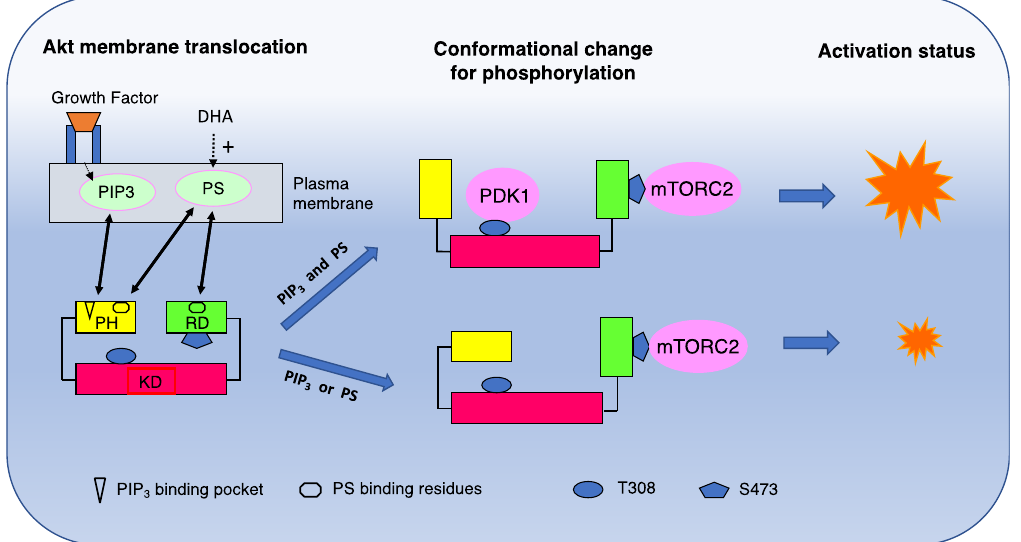
Figure 4. Molecular mechanism for PS-facilitated Akt activation. Upon stimulation of a growth factor receptor, cytosolic Akt is recruited to the plasma membrane though interacting with PIP 3 and PS. The membrane interaction causes conformational changes of Akt, exposing T308 and S473 for phosphorylation by PDK1 and mTORC2, respectively. While S473 in the regulatory domain can be exposed by interacting with either PS or PIP 3 , both lipids are required for the conformational change of the PH domain to expose T308 in the kinase domain for full activation of Akt. DHA, docosahexaenoic acid; PS, phsphatidylserine; PH, pleckstrin homology domain; RD, regulatory domain; KD, kinase domain. Adapted from reference [25].